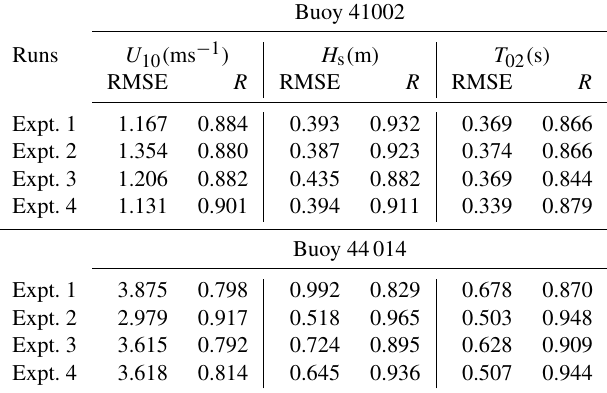
Table 2. Root mean square error (RMSE) and correlation coefficient ( R ) for mean wind speed U 10 at 10m elevation, significant wave height H s , and wave period T 02 between model experiments and buoys 41002 and